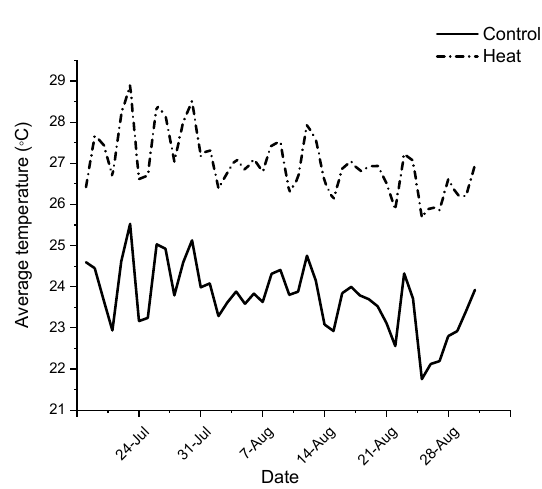
Figure 2. Daily average root-zone temperature recorded through the growing season for elevated soil temperature and control treatments.